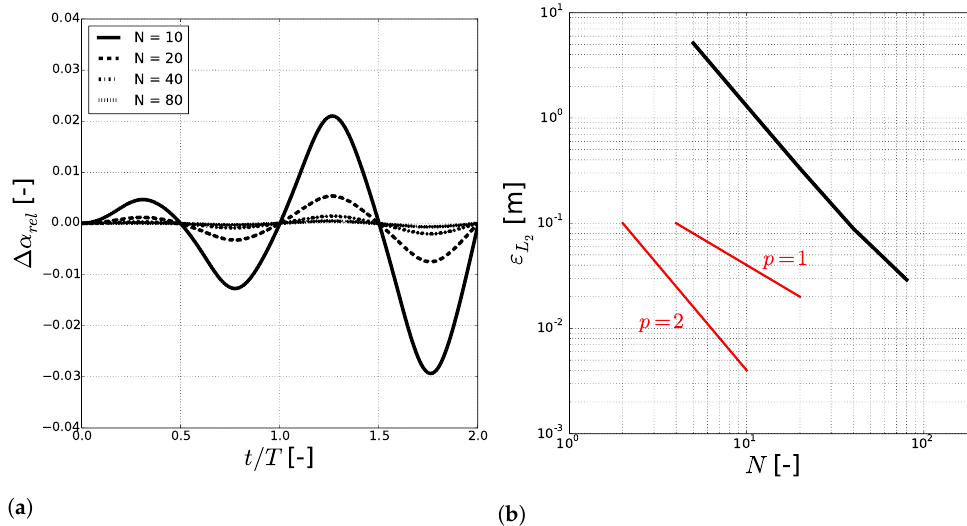
Figure 4. Convergence study for the angle α of the rigid pendulum in a gravity field. ( a ) Differences of the angle between the numerical solutions with N = 10 to N = 80 and the theoretical solution over two periods. ( b ) Spatial convergence of the L 2 norms of error. The red lines correspond to convergence rates of p = 1 and